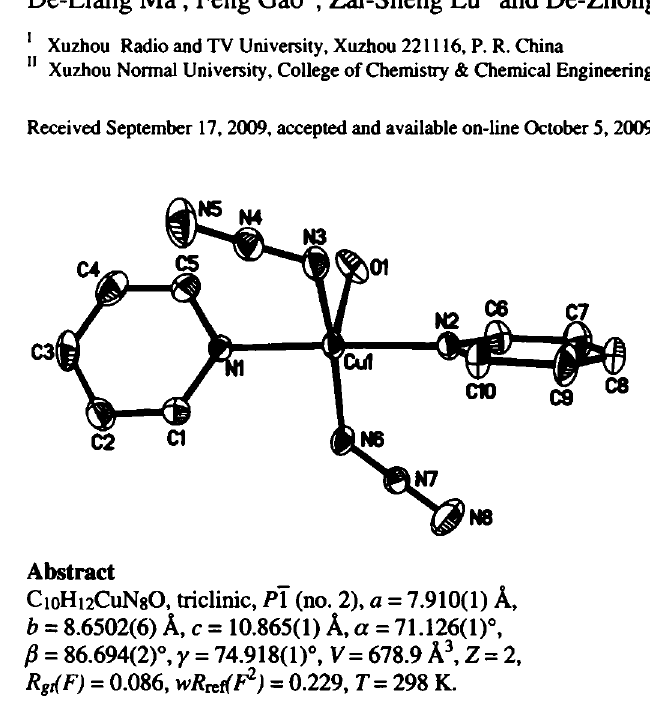
Table 1. Data collection and handling.